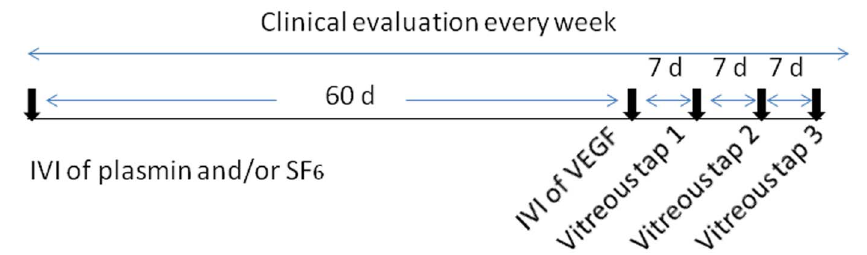
Figure 1. Study design. The time points of treatments and the clinical evaluation. D, days. IVI, intravitreal injection.